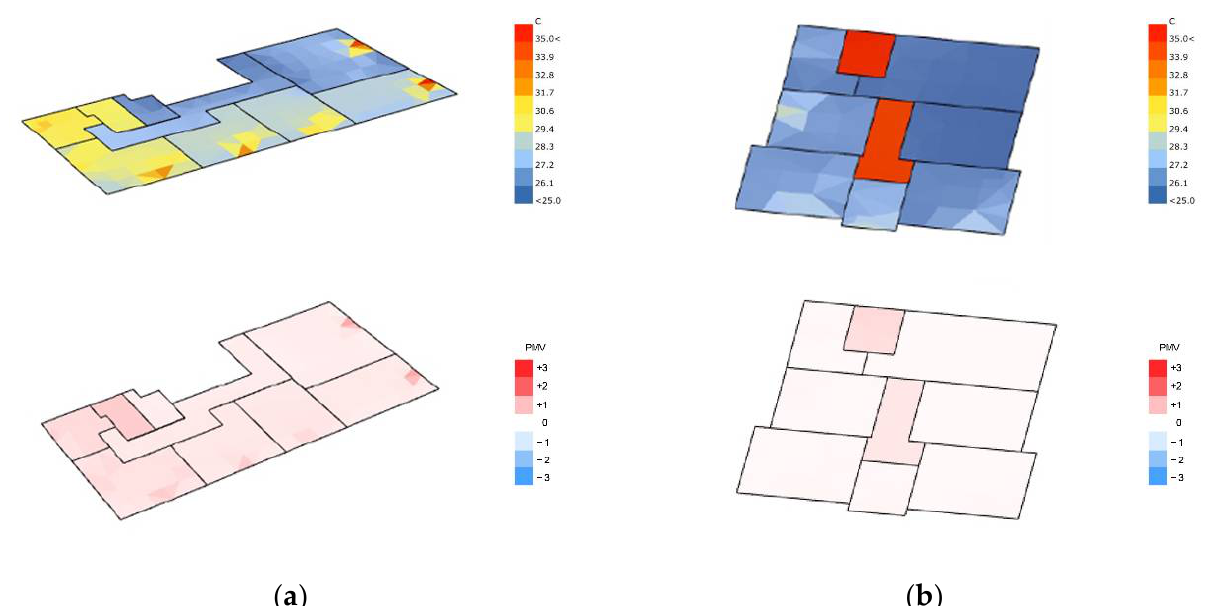
Figure 17. The indoor output of air temperatures and PMV considering building retrofit and outdoor climate adaptive redevelopment: ( a ) The simulated flat for the Materdei building; ( b ) The simulated flat for the Ponticelli building.